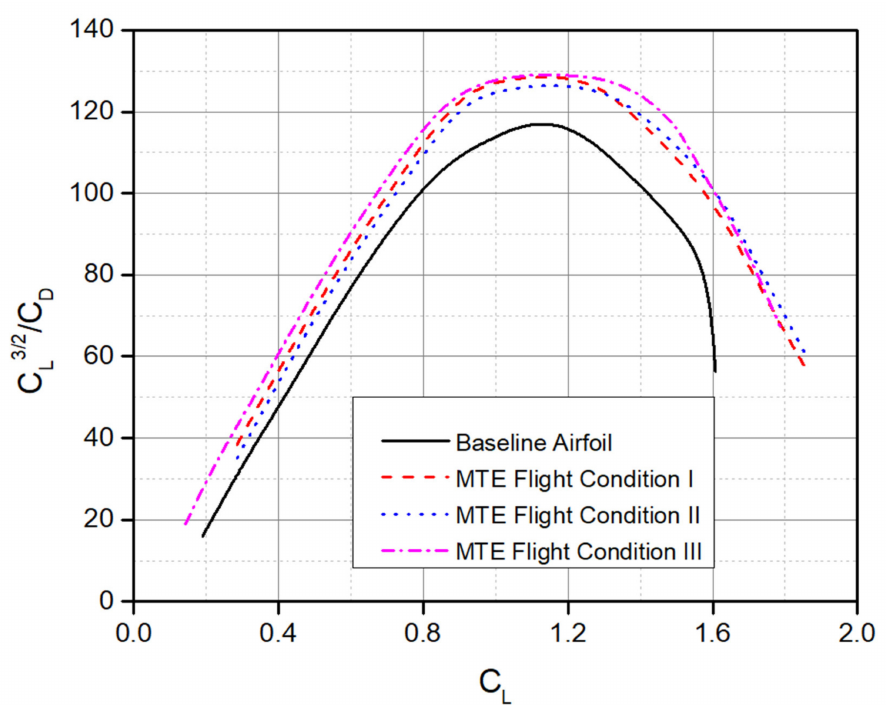
Figure 24. Comparison of the endurance performance for baseline and MTE airfoils.